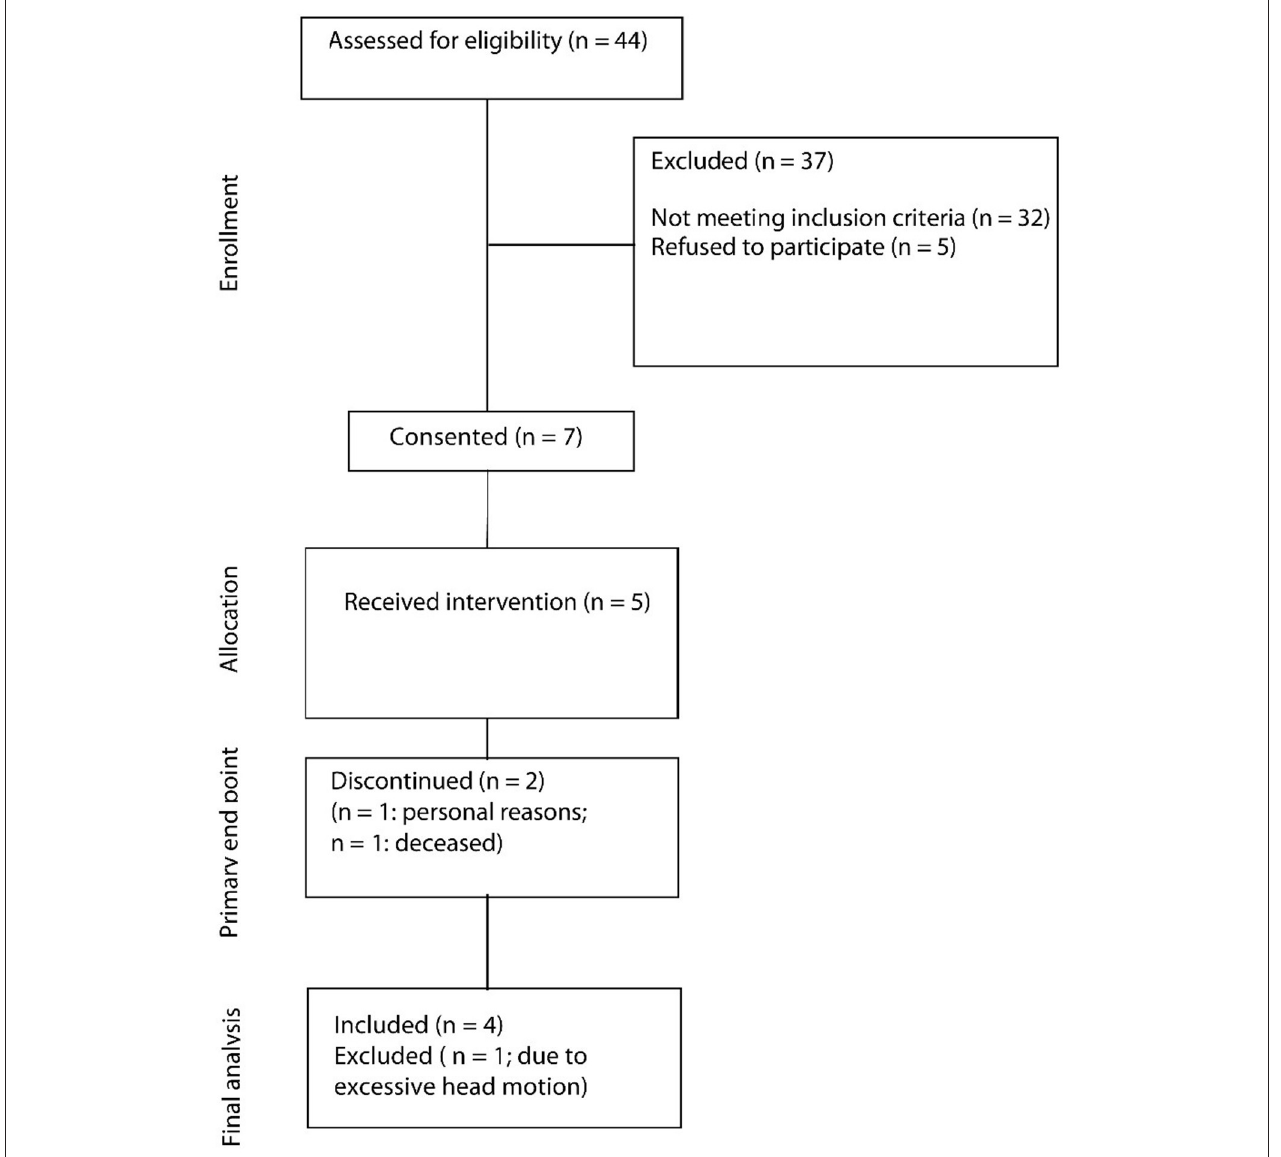
FIGURE 2 | CONSORT recruitment flow